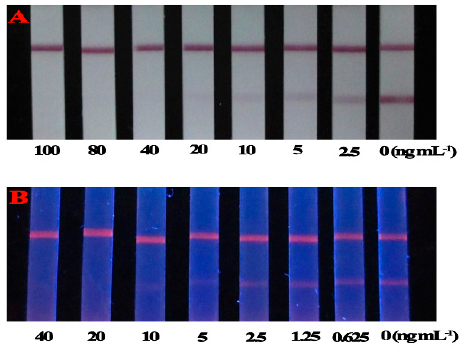
Figure 3. Detection of T-2 in PBS by the CG-LFIA ( A ) and FMs-LFIA ( B ).